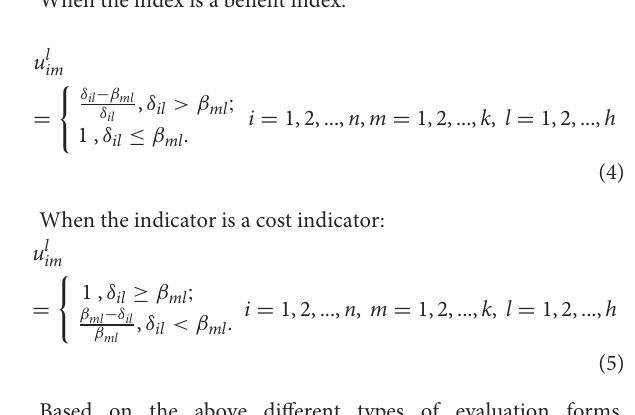
Where benefit indicators are positive indicators (i.e., the larger the better), and cost indicators are negative indicators (i.e., the smaller the